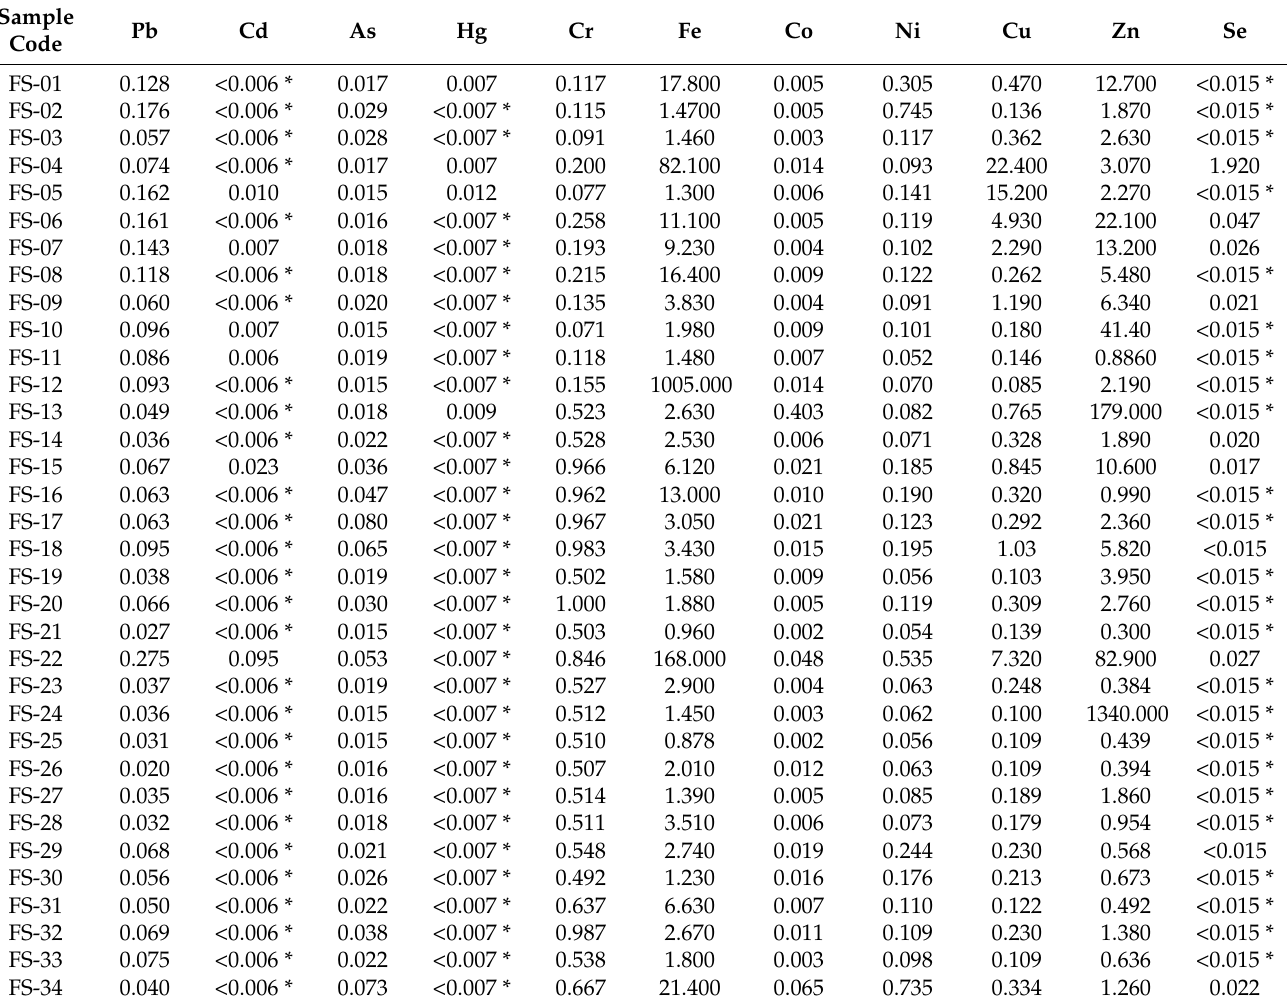
Table 2. Estimated absolute concentration [mg/kg] of toxic metals and micronutrients in the tested food